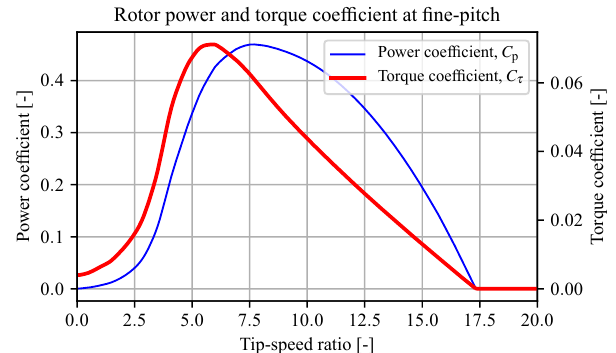
Figure 6. Rotor power and torque coefficient curve of the ro- tor obtained from a BEM analysis performed on measured blade- geometry data. The maximum power coefficient C p , max of 0 . 48 is attained at a tip-speed ratio of 7 . 8. The maximum torque coefficient of C τ, max is given by 7 . 2 × 10 − 2 at a lower tip-speed ratio of 5 . 9.